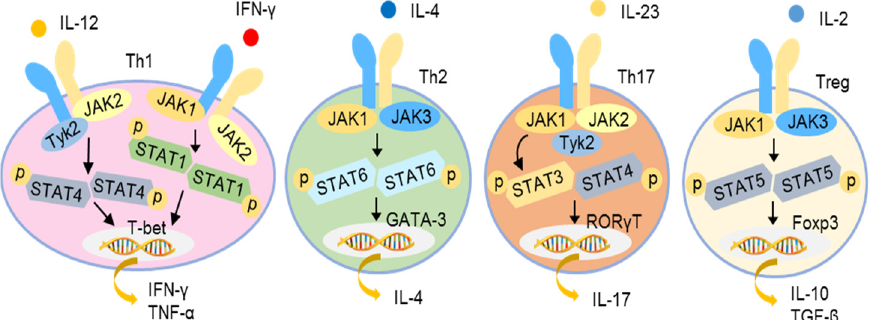
Figure 4. JAK-STAT signaling pathways of different cytokines for initiation of T helper responses. Different combinations of JAKs are activated by different cytokine receptors to promote the phos- phorylation and dimerization of different STAT proteins as illustrated. The dimerized STATs translocate to the nucleus to activate the transcription of target genes and initiate different Th responses as illustrated.